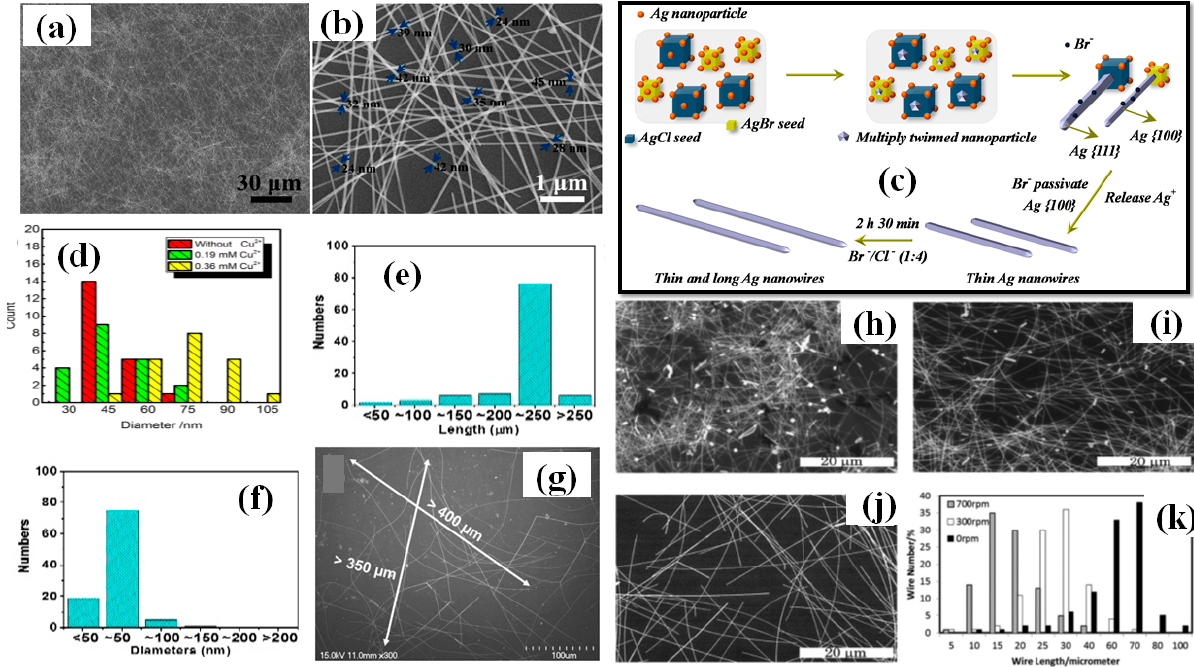
Figure 7. ( a ) Low-magnification FE-SEM image of the synthesized AgNWs; and ( b ) representative high-magnification FE-SEM image of the synthesized AgNWs ( c ) A Schematic representation of the proposed formation mechanism of high aspect ratio AgNWs using Br-ions (adapted from [113] with permission from MDPI, 2019) ( d ) A statistical analysis diameter of AgNWs under different condition (adapted from [114] with permission from Elsevier, 2016).The distribution of ( e ) length, and ( f ) diameters in a count of 200 Ag NWs ( g ) SEM images of synthesized AgNWs (scale bar 100 µ m) (adapted from [111] with permission from ACS publications, 2017). ( h – j ) The SEM images of AgNWs prepared at 130 ◦ C with stirring speeds of ( h ) 700, ( i ) 300 and ( j ) 0 rpm (the inset photos have a scale bar of 30 µ m. ( k ) Statistics of the length distribution of AgNWs with different stirring speeds (adapted from [117] with permission from Royal Society of Chemistry,